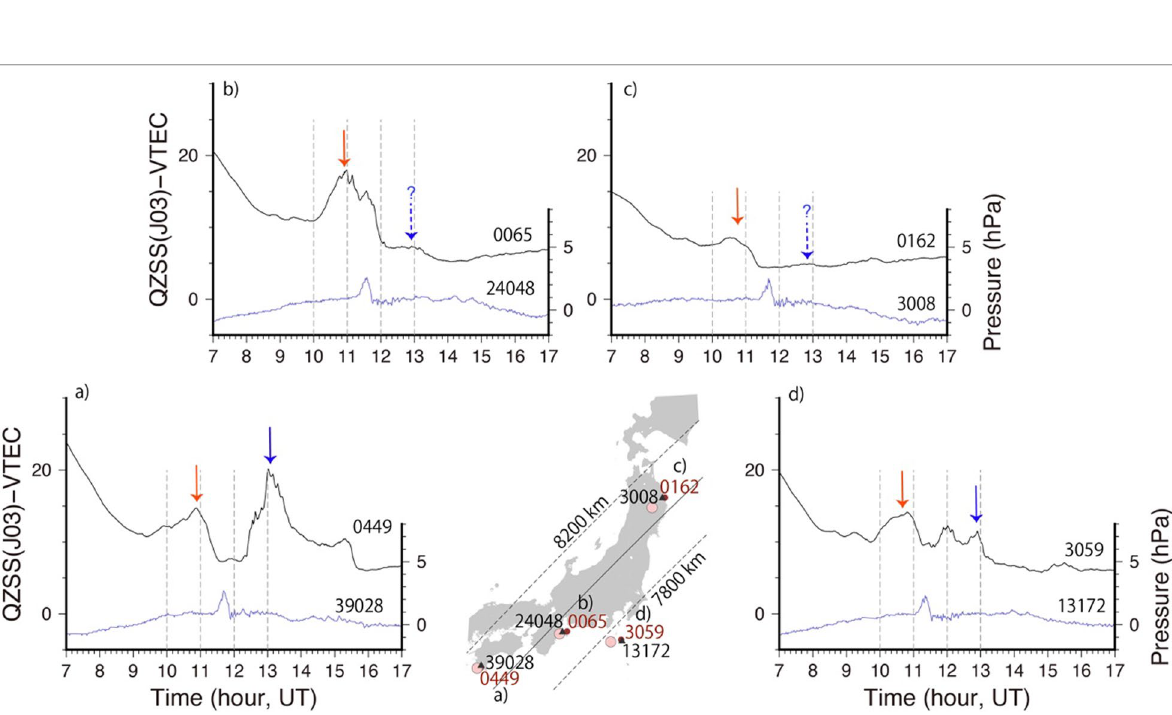
Fig. 9 Comparison of the pressure anomaly (blue) and VTEC (black) with the quasi-zenith orbit satellite J03, with nearly vertical line-of-sight, around the first passage of LW. Both the ground GNSS stations (red) and their SIPs at 11.7 UT (pink) are close to the barometers. See Fig. 8 caption for